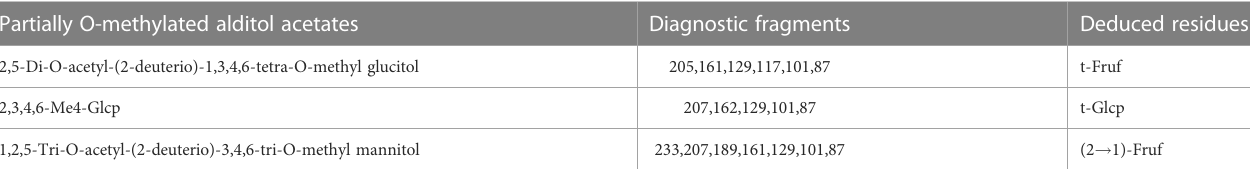
TABLE 1 Linkages of PGNP determined via GC – MS methylation analysis. Partially O-methylated alditol acetates Diagnostic fragments Deduced